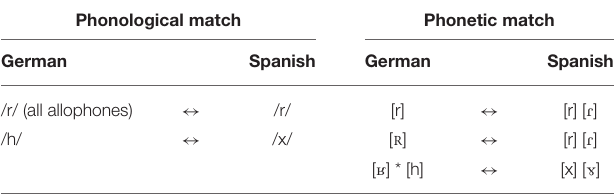
TABLE 1 | Summary of most likely cross-language perception patterns for Spanish learners of German based on phonological match (left) and phonetic match based on manner of articulation